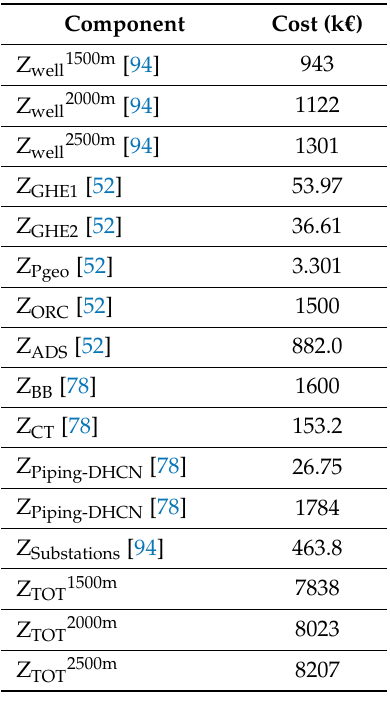
Table 6. Component plant